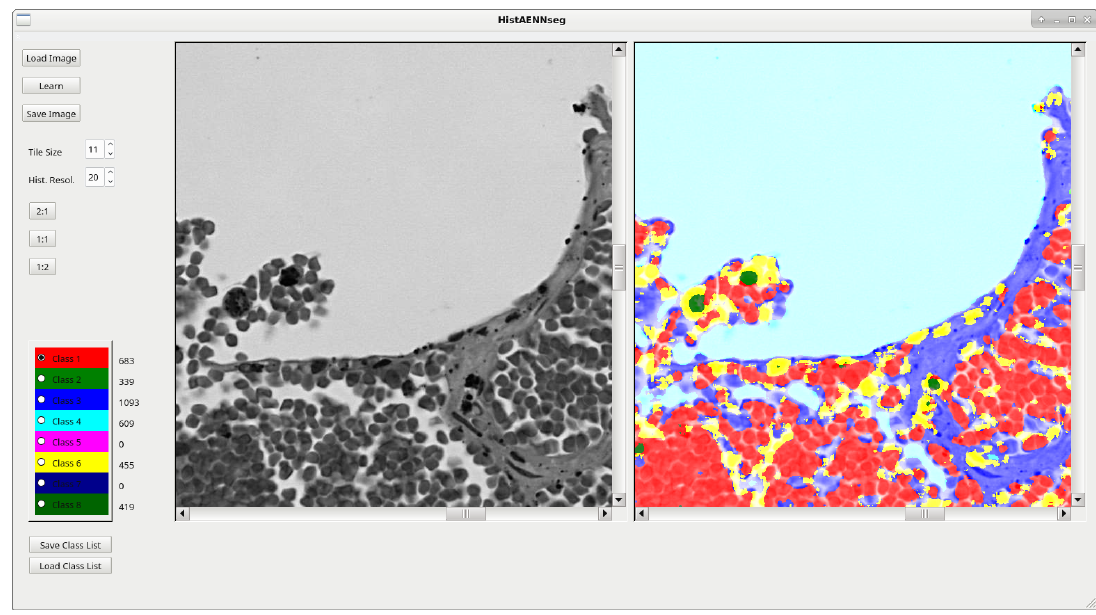
Figure 5. Exemplary view of